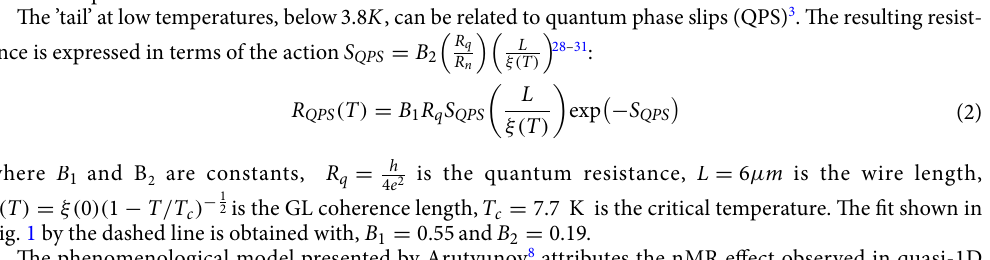
Fig. 1 by the dashed line is obtained with, B 1 = 0.55and B 2 = 0.19